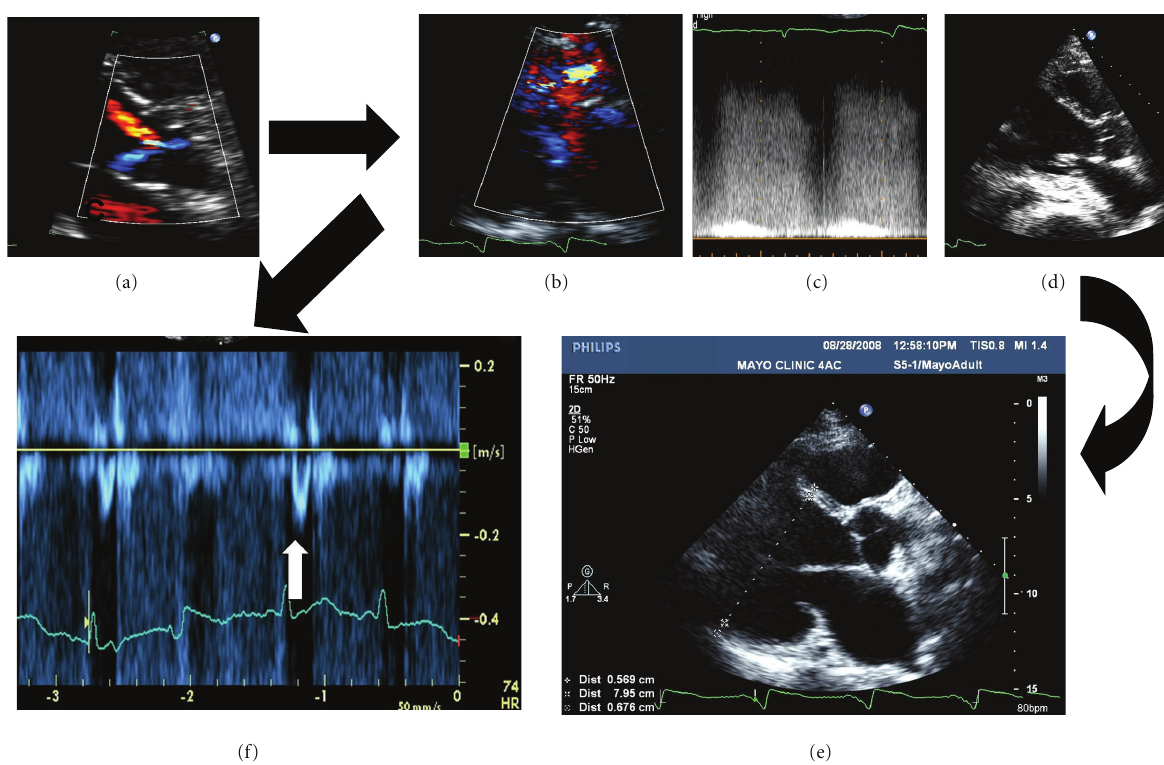
Figure 1: Aortic regurgitation after implantation. Patient presented with new onset heart failure 6 months after LVAD implantation. LVAD evaluation showed increased power and LVAD flow. (a) Pre-LVAD parasternal long axis view showing mild diastolic aortic regurgitation. (b), (c), and (d) Immediately after LVAD, blood is pumped from the LV into the aorta creating subphysiological LV pressures. The retrograde aorta to LV gradient increases and continues throughout the cardiac cycle, including most of the systolic phase. Aortic regurgitation has increased in volume and takes place during most of the cardiac cycle. (e) and (f) Six months after LVAD surgery. Aortic regurgitation deteriorated secondary to closed aortic valve encountering high retrograde pressure gradient throughout the cardiac cycle. The progressing regurgitant volume increased left ventricular diameter, which in turn amplified LVAD preload and output. Pump output spiraled up to very high levels, while actual systemic blood flow fell. The end result was a “futile cycle” consisting of high pump flow, low total cardiac output, and high left ventricular and left atrial